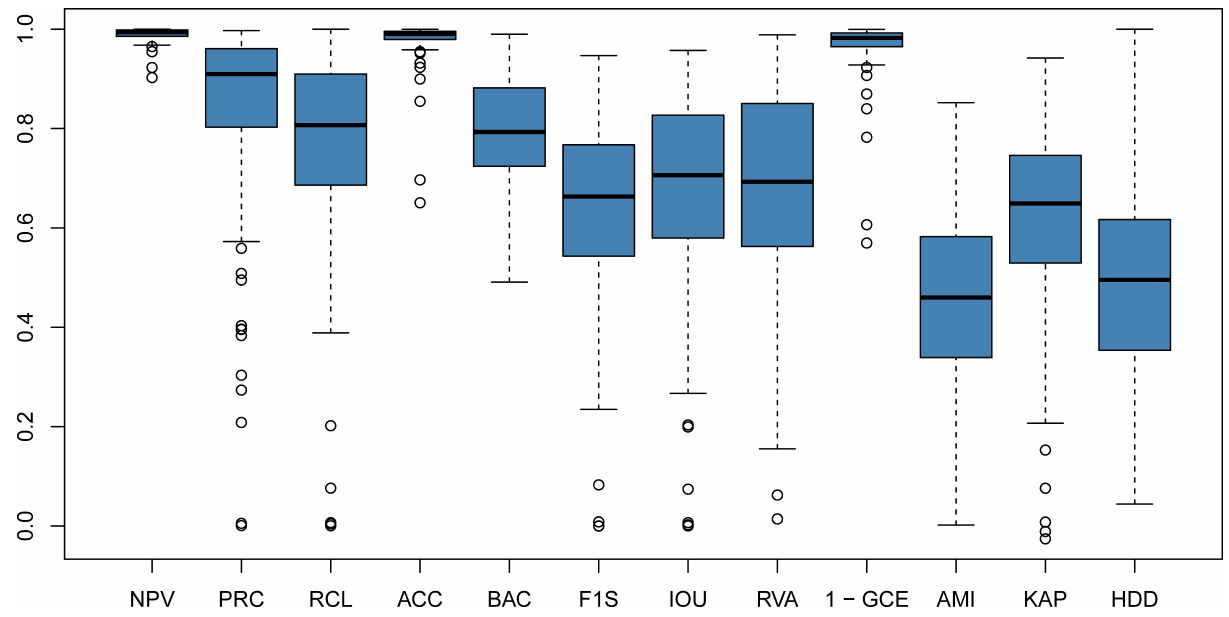
Figure 2. Boxplots of the raw metrics’ values showing the discrepancies in their distributions. The HDD, which takes values in R + , is transformed as HDD /max ( HDD )